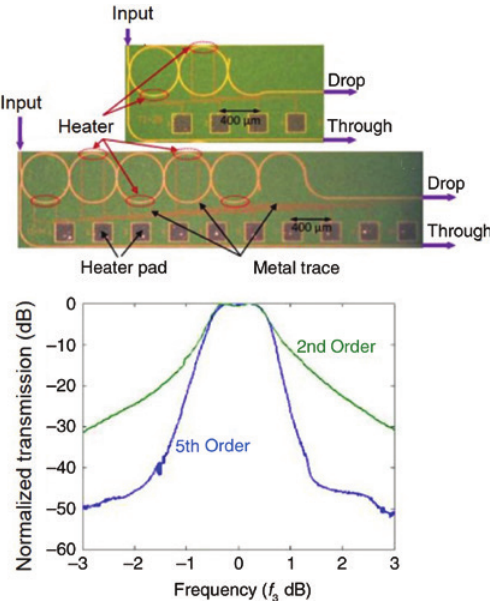
Figure 22: A tunable bandpass filter using a fifth-order coupled ring resonator in silicon [99] (Copyright in 2010, Optical Society of America).